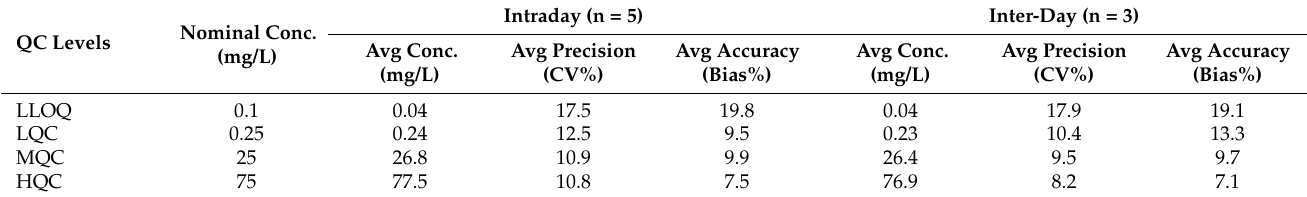
Table 4. Intra-day and inter-day average (avg) precision and accuracy assessed at four concentration levels (LLOQ, LQC, MQC and HQC) five times (intra-day) in three different analytical runs (inter-day) for VBR.